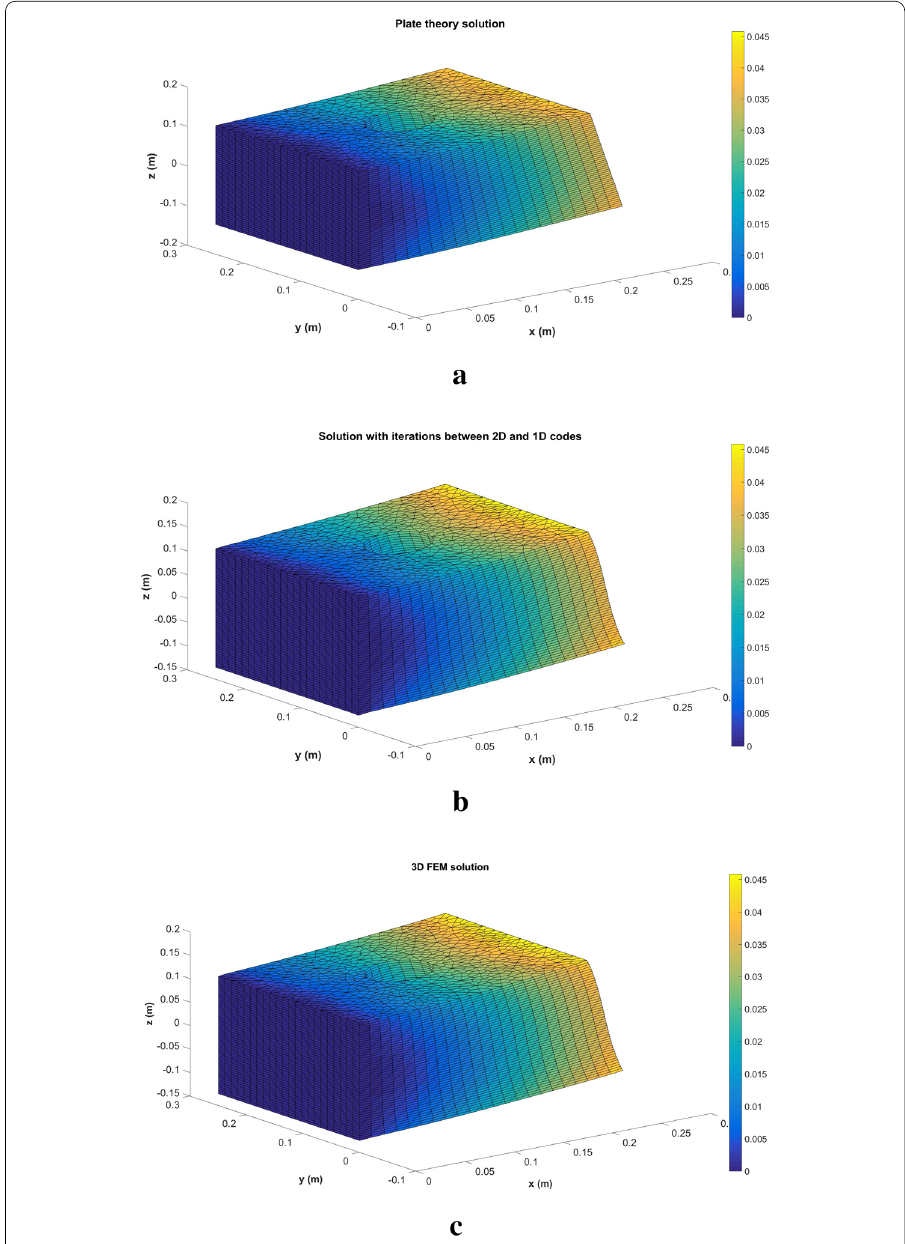
Fig. 4 Displacement field using: plate theory ( a ), minimally-intrusive fully 3D separated plate formulation ( b ), 3D FEM ( c )